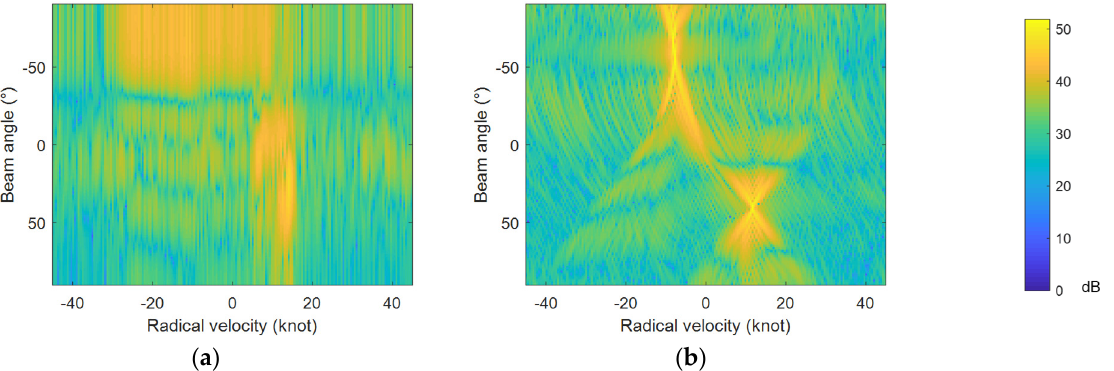
Figure 19. Space–time two-dimensional spectrum before and after motion compensation when both velocity and heading change: ( a ) results before motion compensation, ( b ) results after motion compensation.